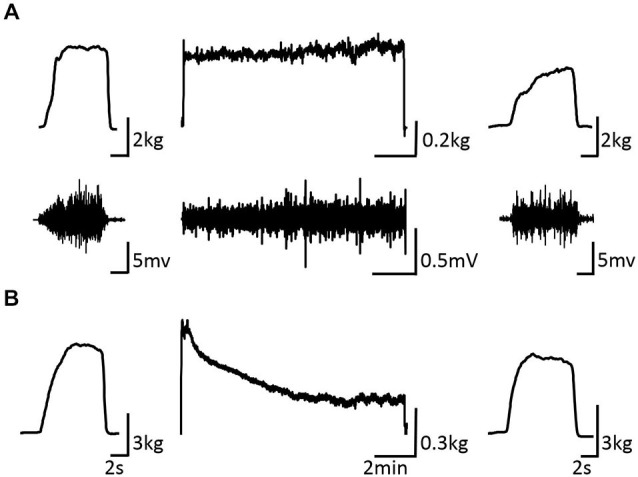
Pre-, during-, and post-task differences in electromyographic activity. (A) VC task: the upper stand shows the force waveform, whereas the lower stand shows the electromyographic waveform. (B) Tetanic ES task shows the force waveform. It shows the electromyographic activity during the intervention and maximum muscle force pre- and post-intervention of typical subjects.